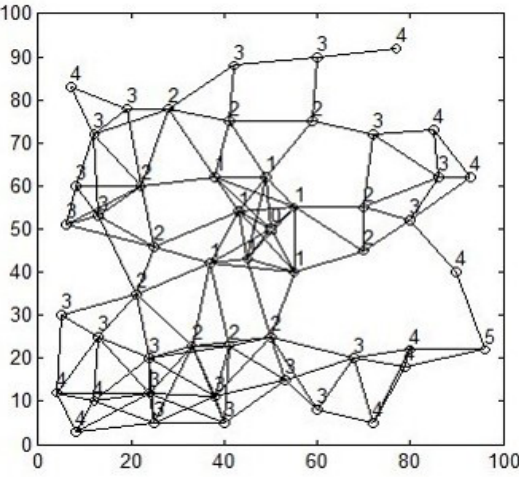
Figure 1. Hop count-classification network topology in an area of 100 m × 100